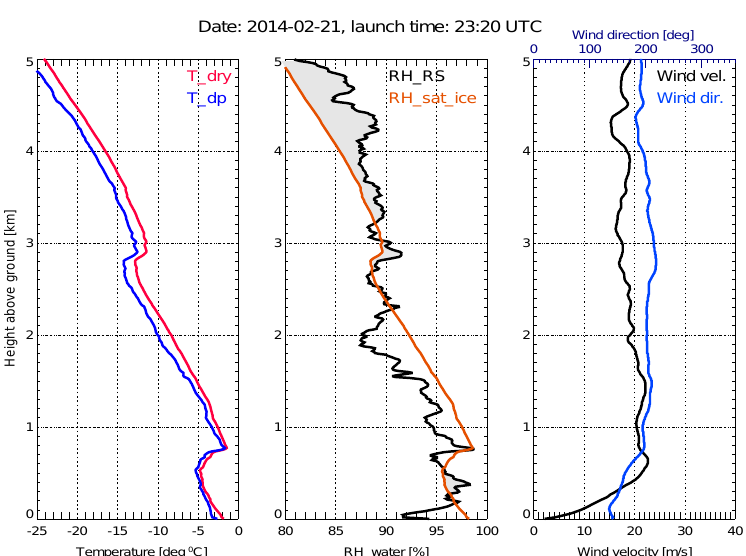
Figure 1. Vertical profiles of temperature (blue, left) and dew point temperature (red, left), relative humidity (middle, black), as well as hori- zontal wind speed (right, black) and wind direction (right, blue) from a radiosonde launched at 23:20UTC (23.33UTC) on 21 February 2014 in Hyytiälä. The red line in the middle panel refers to the humidity at which the air is saturated with respect to ice; i.e., if the relative humidity is to the right of the red line, the air is supersaturated ice (grey shading).